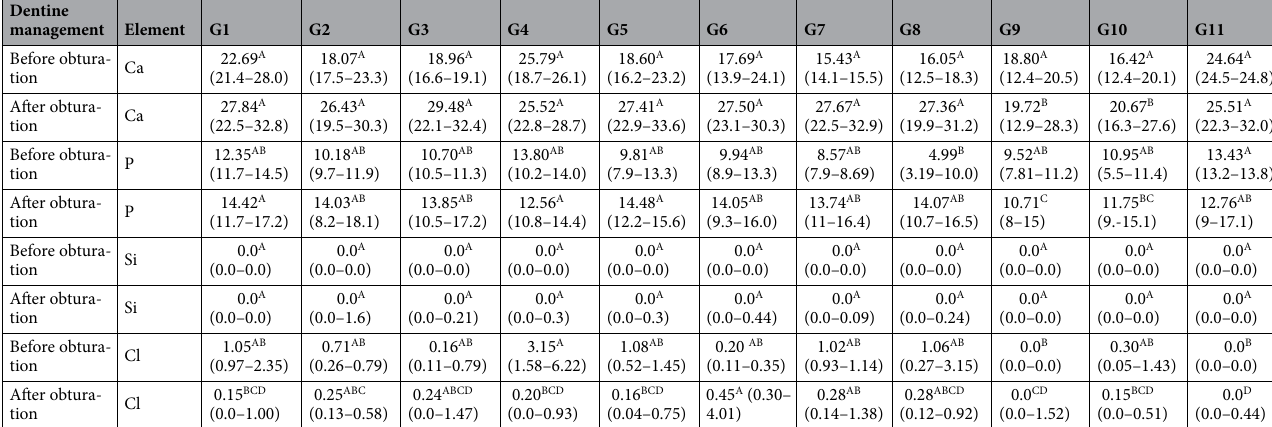
Table 3. Median, Minimum and Maximum values of the percentage of calcium (Ca), phosphate (P), chlorine (Cl) and silicon (Si) obtained from the Energy Dispersive Spectroscopy (EDS) chemical analysis on dentin surface after immersion in the irrigation solutions (G1–G11) as indicated in protocols A–G which are detailed in Table 1, before and after root canal obturation. Different capital letters in rows indicate statistically significant intragroup differences (Kruskal–Wallis with a Dunn post hoc P value < 0.05).